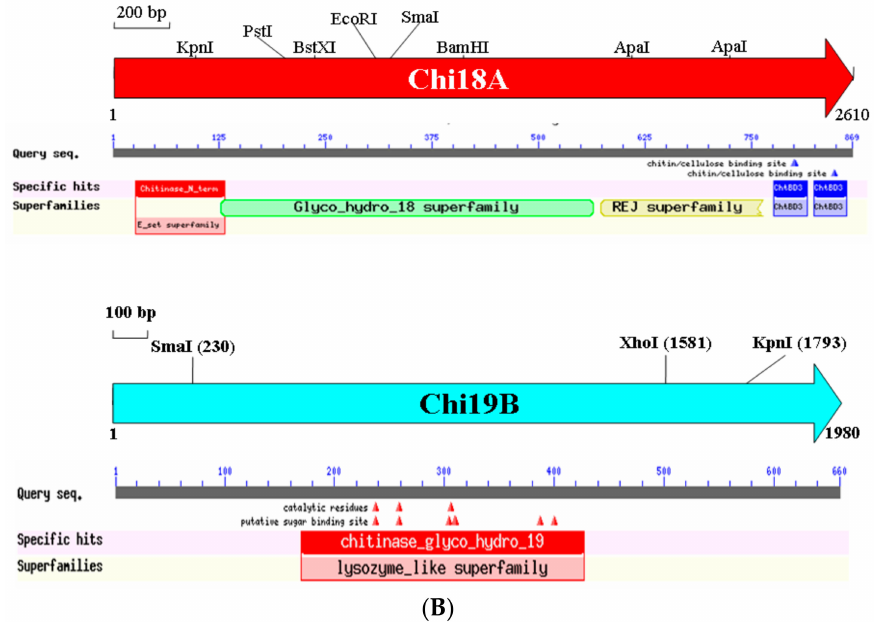
Figure 4. Physical maps of the insert DNA of SK10-5 ( A ), and Chi18A and Chi19B ( B ).